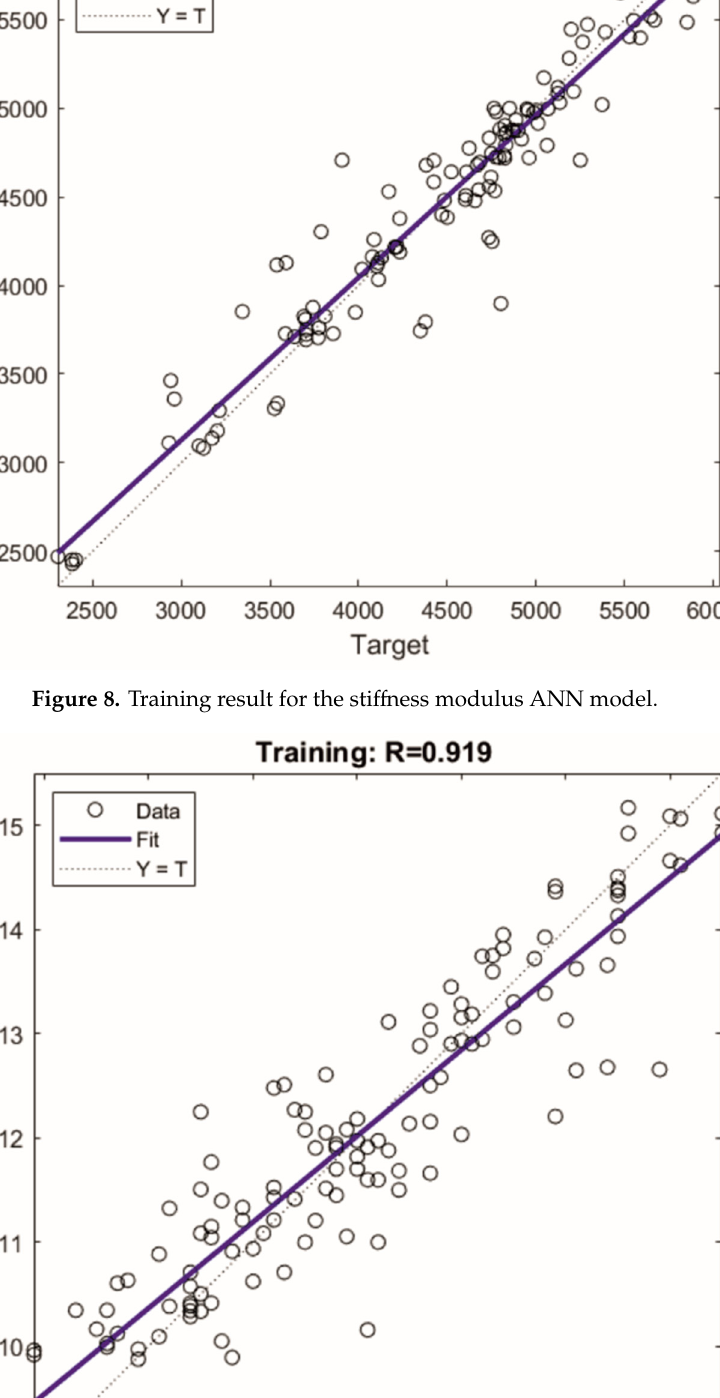
Figure 7. ANN final architecture to predict the Marshall quotient.